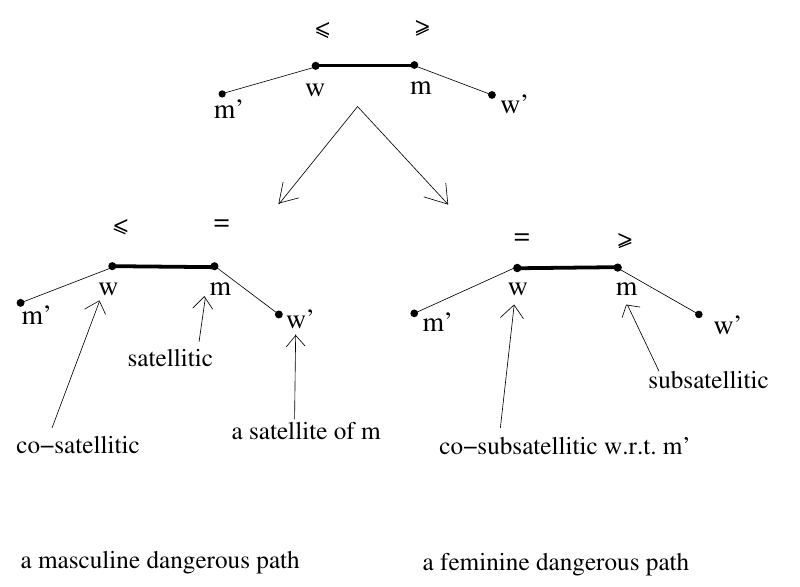
Figure 1. The description of a dangerous path and its two types: a feminine dangerous path and a masculine dangerous